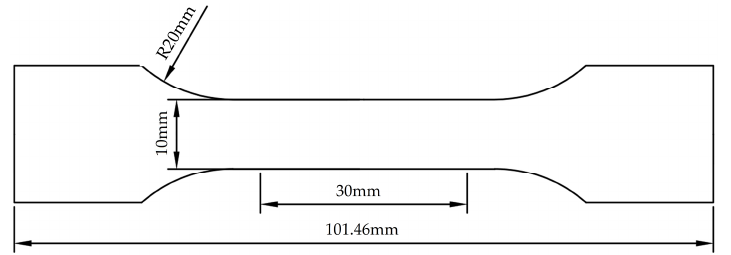
Figure 4. Dimension drawing of dog bone tensile specimen.